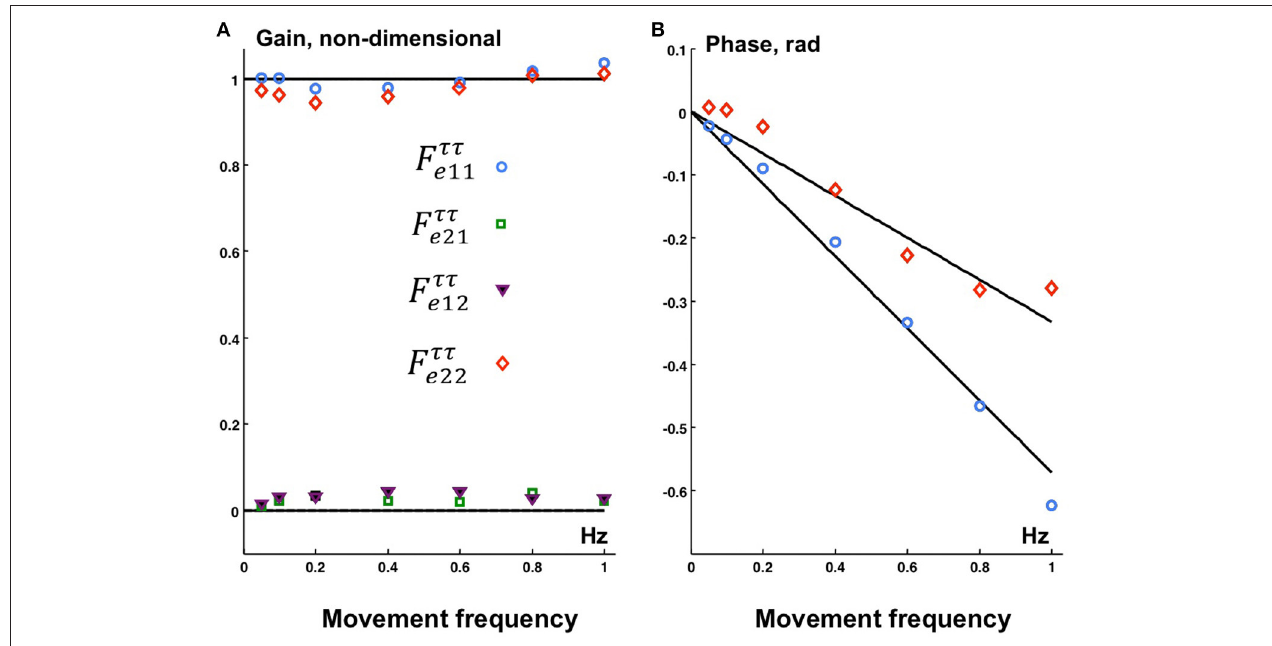
FIGURE 5 | The gain (A) and phase (B) characteristics of theoretical transfer function F ττ t (curves) calculated according to (13) with joint torque delays τ 1 = 0.091s (ankle) and τ 2 = 0.053s (hip) and experimental F ττ e (markers) for the transformation of the controller output joint torques to the actual joint torques . Experimental data points: ◦ F ττ e 11 , (cid:3) F ττ e 21 , H F ττ e 12 , ♦ F ττ e 22